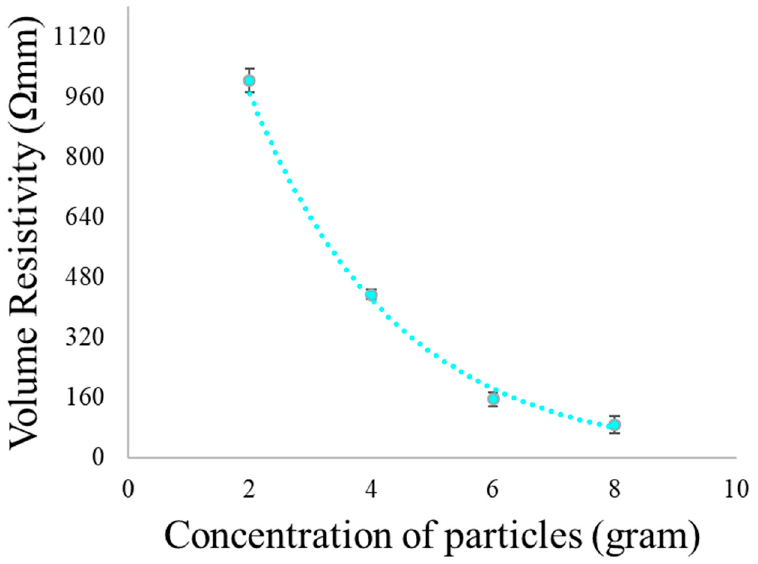
Figure 12. The conductivity of the developed composites.